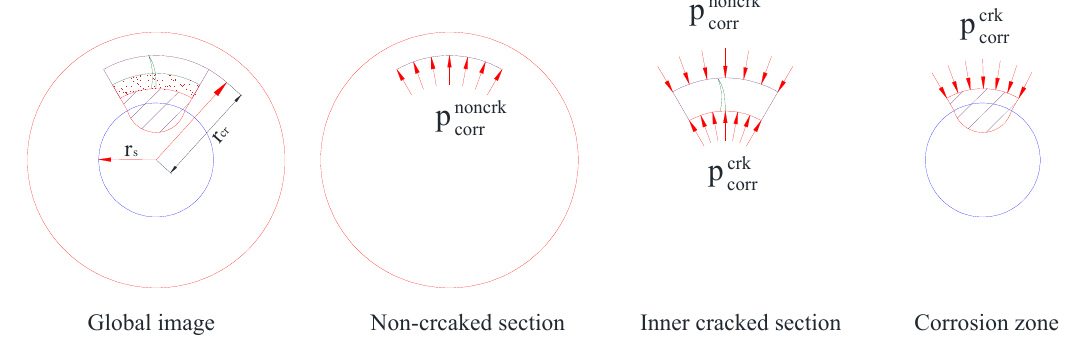
Figure 6. Cracked thick-walled cylinder with expansion stress.